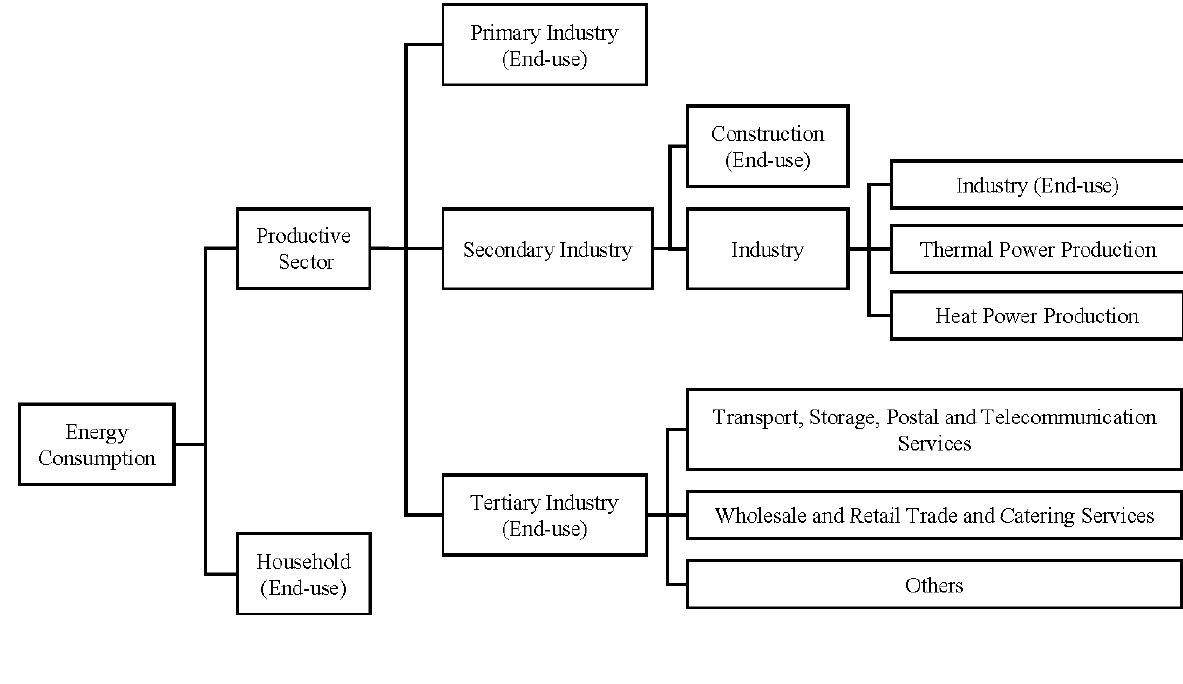
Figure 2. The division of energy consumption sectors. Note: As the electricity and heat consumption do not produce carbon emissions directly, their carbon emissions are produced indirectly from fossil fuels combustion in the production process. In addition, hydropower, nuclear power and wind power almost do not produce carbon emissions. Therefore, carbon emissions of power generation calculated in this paper only include carbon emissions of electricity generated by thermal power plants. To avoid double counting, indirect carbon emissions of thermal power and heat in End-use part no longer included in the total carbon